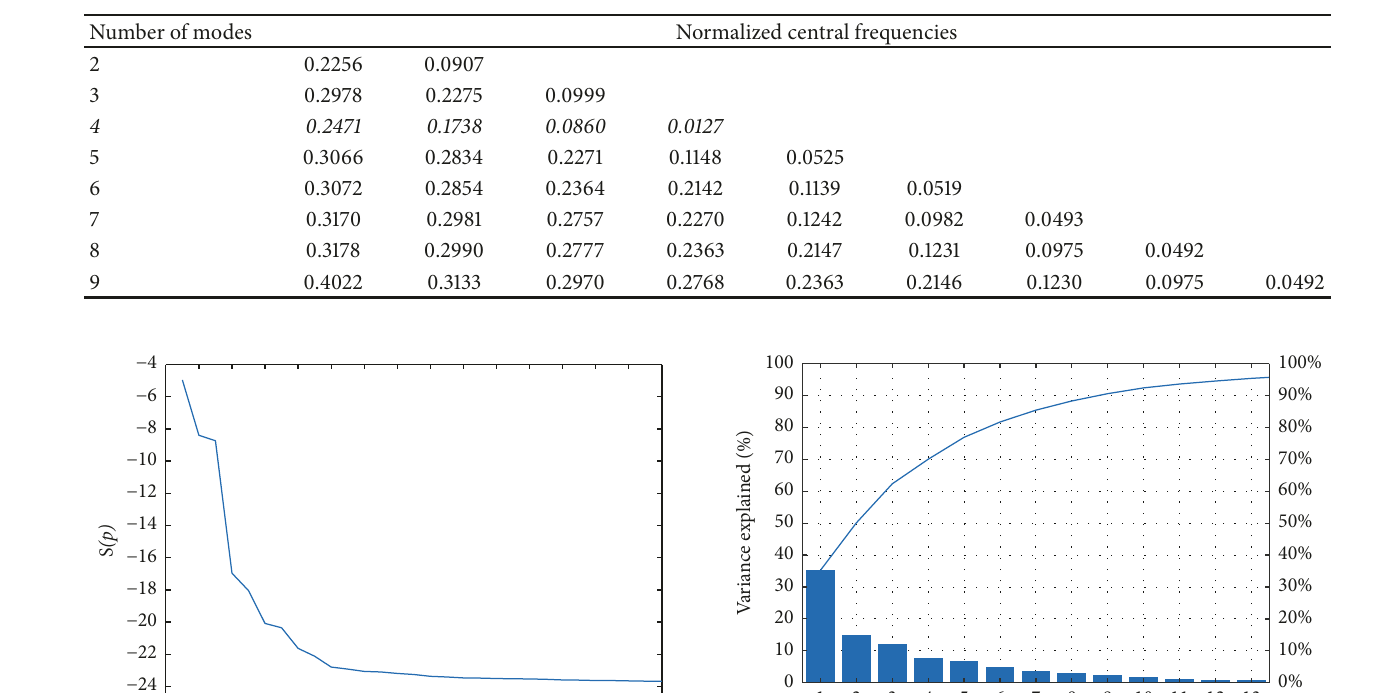
Table 3: Normalized central frequencies with different K values.